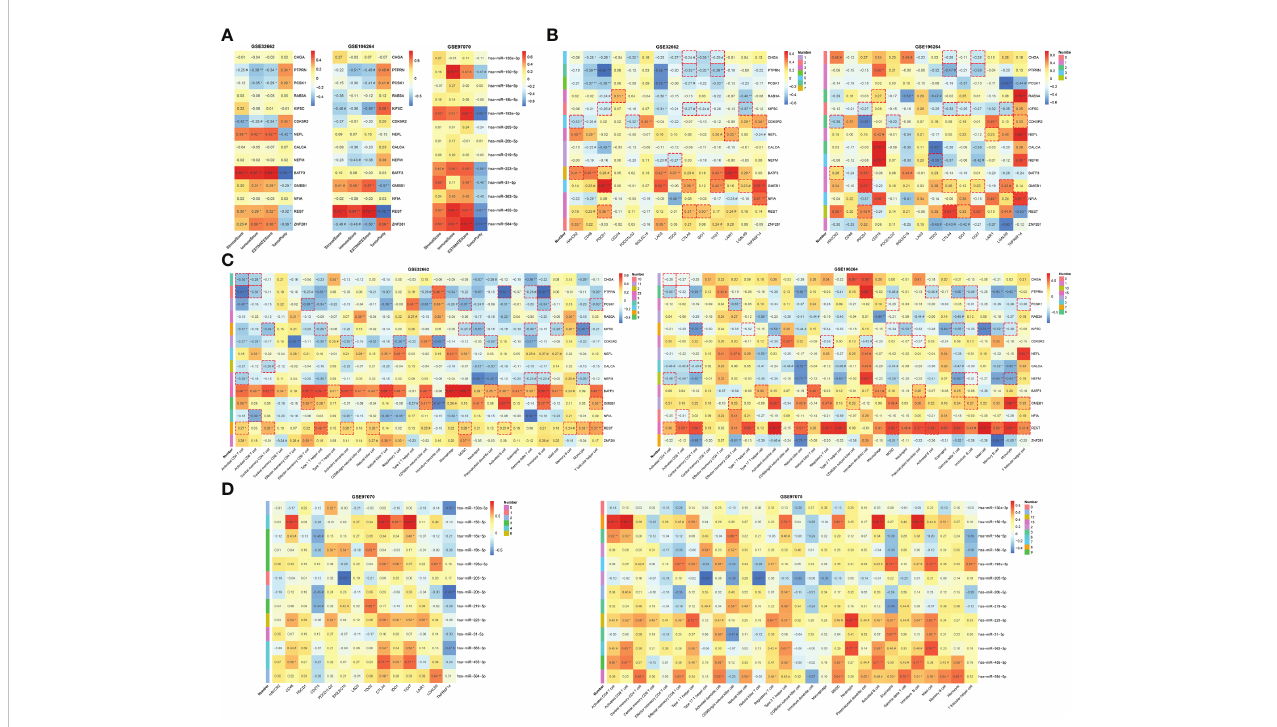
FIGURE 7 Correlation of individual biomarkers in TF-mRNA-miRNA network with immune characteristics in MTC. (A) The relationships of hub genes, TFs and miRNAs with stromal score, immune score, ESTIMATE score and tumor purity. (B) The relationships of hub genes and TFs with ICGs. (C) The relationships of hub genes and TFs with immune in fi ltration. (D) The relationships of miRNAs with ICGs and immune in fi ltration. ICGs, immune checkpoint genes. #, p < 0.1; *p < 0.05; **p < 0.01; ***p < 0.001.